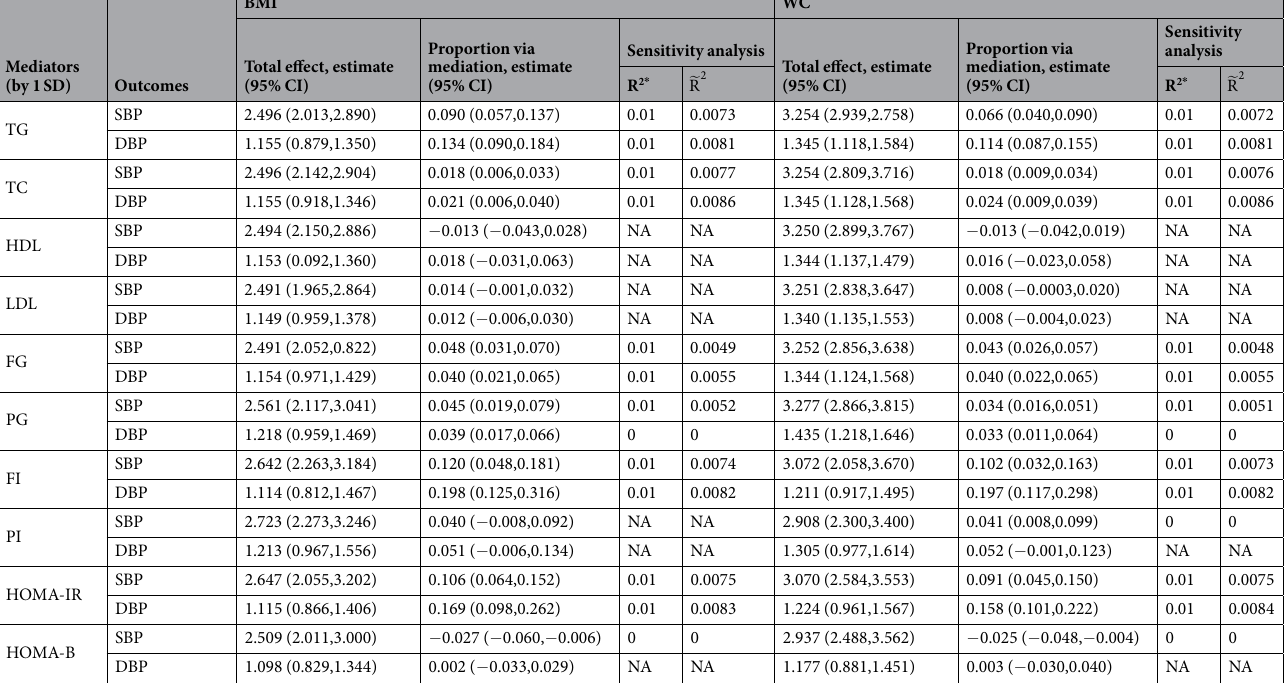
Table 3. Mediation analysis between BMI/WC and blood pressure in the Harbin Cohort Study on Diet, Nutrition and Chronic Non-Communicable Diseases (HDNNCDS, 2012). Abbreviation: BMI, body mass index; WC, waist circumference; SBP, systolic blood pressure; DBP, diastolic blood pressure; TG, triglyceride; TC, total cholesterol; HDL, high-density lipoprotein; LDL, low-density lipoprotein; FG, fasting glucose; PG, 2-h postprandial glucose; FI, fasting insulin; PI, 2-h postprandial insulin. * Adjusted for age, sex, current smoking, current drinking, exercise regularly, type 2 diabetes, cardiovascular disease, family history of hypertension, and ∼ 2 R total energy intake. R 2 * , the proportion of residual variances and , the proportion of original variances that were explained by the omitted